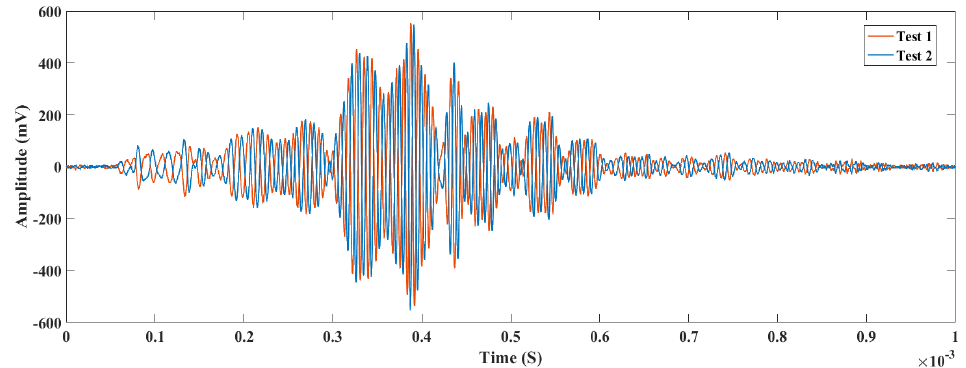
Figure 9. Time-domain response of Sensor 1 of the part with 40% infill at two different times.